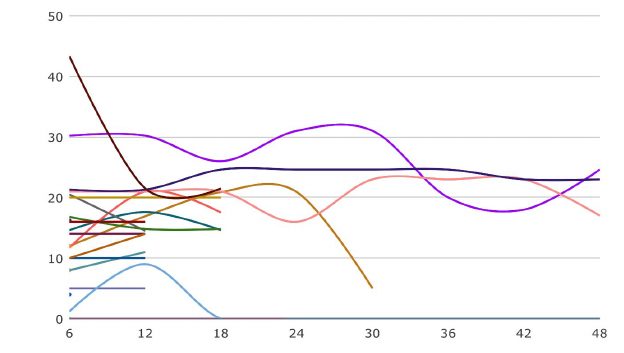
Fig. 1 - Vasoactive inotropic score (VIS) at six-hour intervals from surgery until initiation of extracorporeal life support (ECLS). In four patients, ECLS was initiated within six hours from surgery, hence it could not contribute for VIS